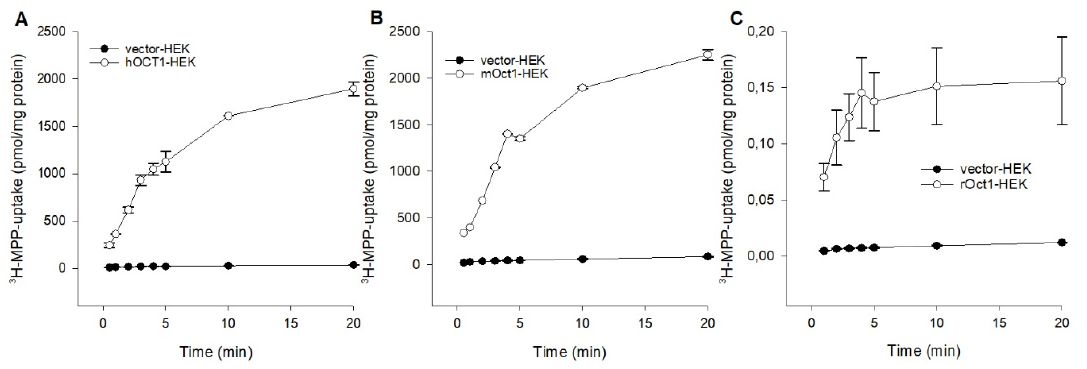
Figure 1. Time dependent uptake of 3H-MPP in ( A ) hOCT1-, ( B ) mOct1-, and ( C ) rOct1-HEK293 cells. Human, mouse, and rat organic cation transporter 1 (OCT1) transfected HEK293 cells were incubated for increasing time points at 37 °C in the presence of labeled 3H-1-methyl-4-phenylpyridinium (MPP) (2 nM), in case of hOCT1 and mOct1 the concentration was filled up to 10 µM with unlabeled MPP. Each data point represents the mean of two or three independent experiments ± average deviation.